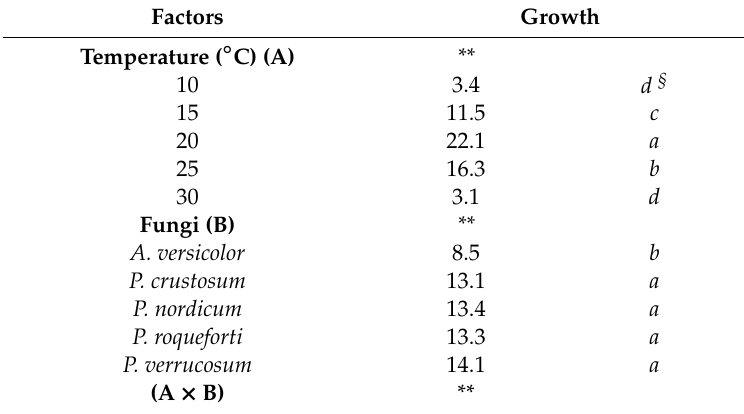
Table 2. Analysis of variance (ANOVA) for fungal growth (colony diameter; mm after 21 days of incubation) in different regimes of temperature (10–30 °C, step 5 °C) and for diverse fungi ( Aspergillus versicolor , Penicillium crustosum , P. nordicum , P. roqueforti, and P. verrucosum ). Standard deviation of growth was reported in parenthesis.